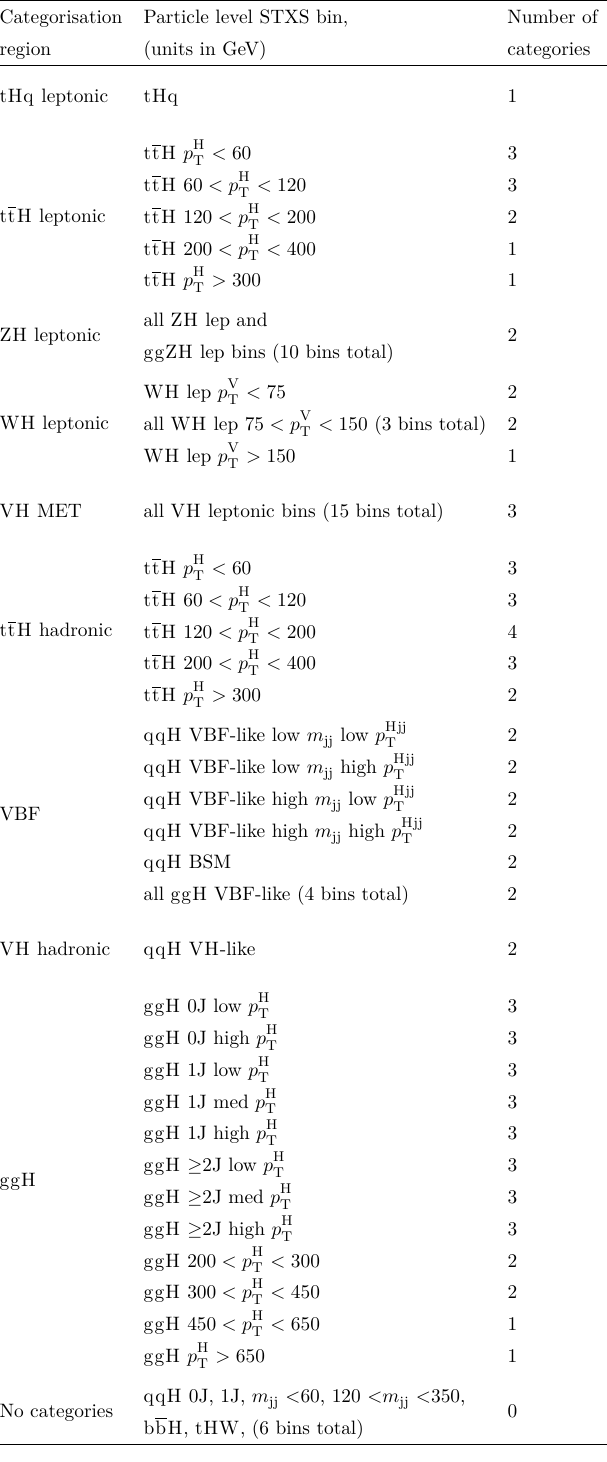
Table 10 . Description of the different categorisation regions, listed in descending order of priority in the first column. The second column shows each targeted STXS bin, or merged group of bins, together with the number of associated analysis categories. The last row contains the bins for which no analysis categories are